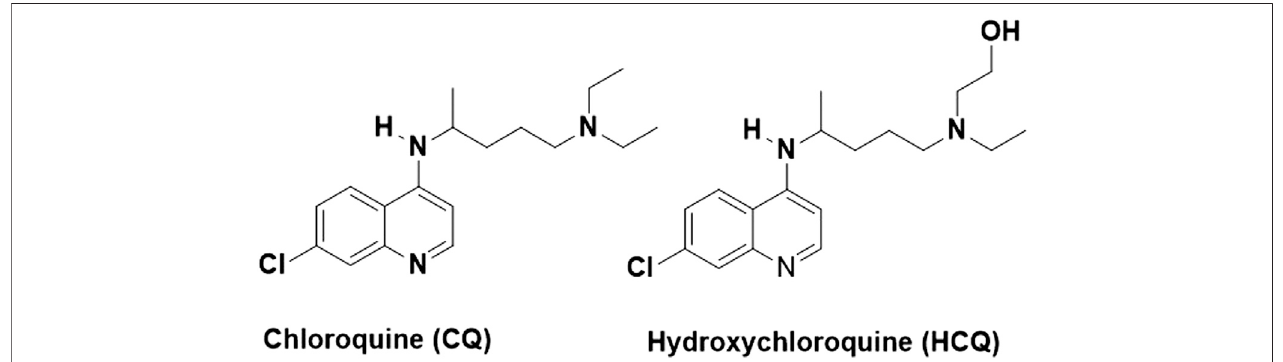
FIGURE 1 | Chemical structures of chloroquine (CQ) and hydroxychloroquine (HCQ).